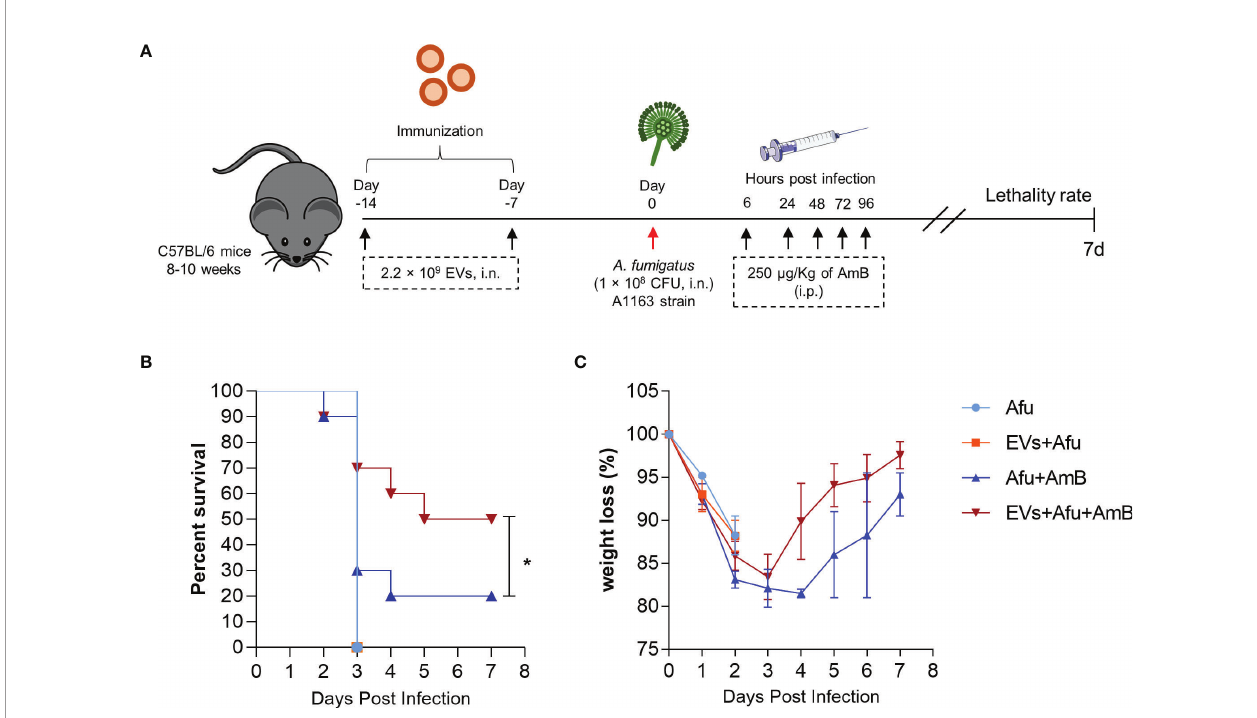
FIGURE 5 | Immunization with A. fumigatus EVs elicits protection after treatment with AmB. C57BL/6 mice were immunized twice with 2.2 × 10 9 EVs and challenged with 1 × 10 8 A. fumigatus conidia. Mice were treated with 250 µg/Kg of AmB (i.p.) 6, 24, 48, 72 and 96 hours post infection (A) . The groups were monitored for lethality rates (B) and weight loss (C) . N = 10 animals per group. *P < 0.05 when compared to the Afu+AmB and